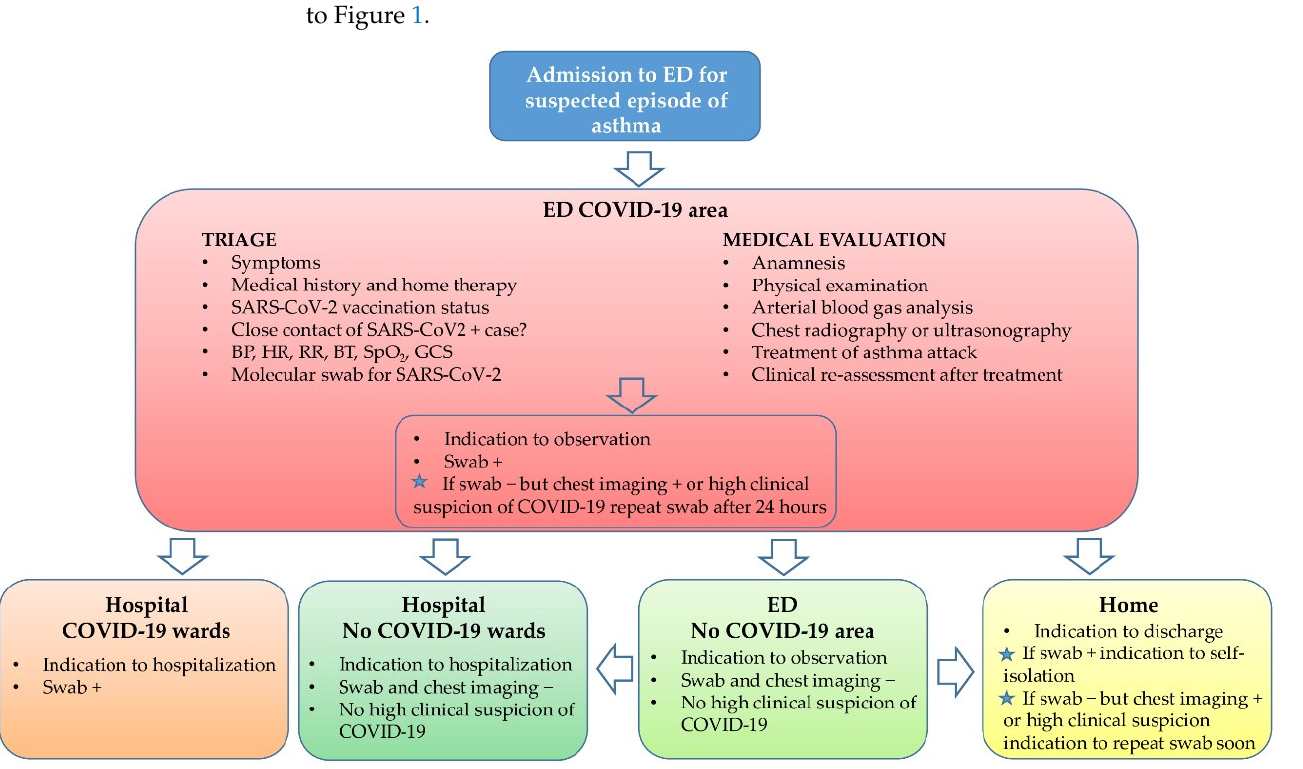
Figure 1. Panel proposal of a rational “COVID-19 path” during a SARS-CoV-2 pandemic for the management of asthma patients in the emergency department (ED) from admission to discharge. Abbreviations and symbols: BP: blood pressure; HR: heart rate; RR: respiratory rate; BT: body temperature; SpO 2 : peripheral arterial oxygen saturation; GCS: Glasgow Coma Scale; +: positive; −: negative; swab: molecular nasopharyngeal swab for SARS-CoV-2.